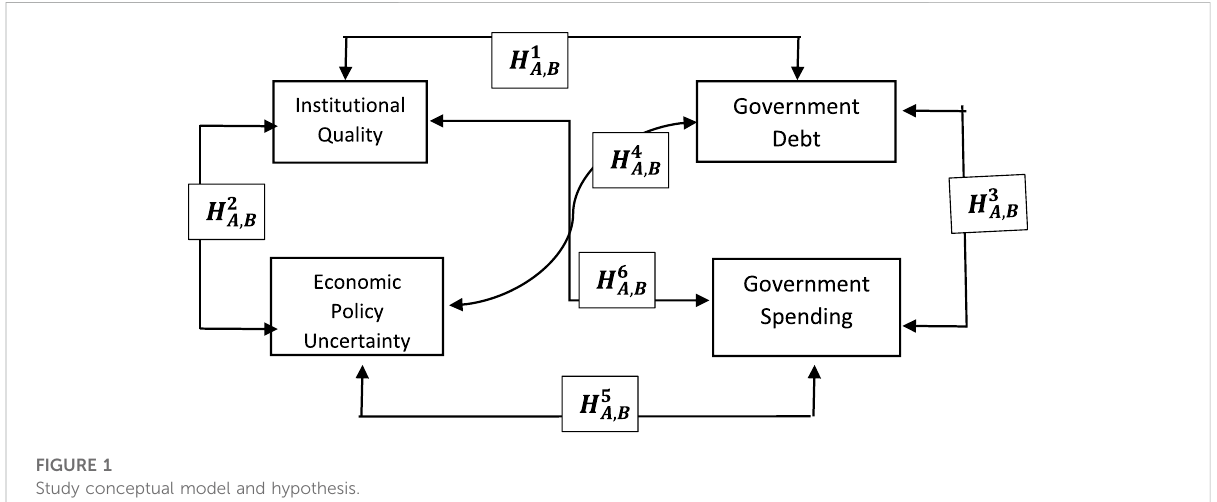
FIGURE 1 Study conceptual model and